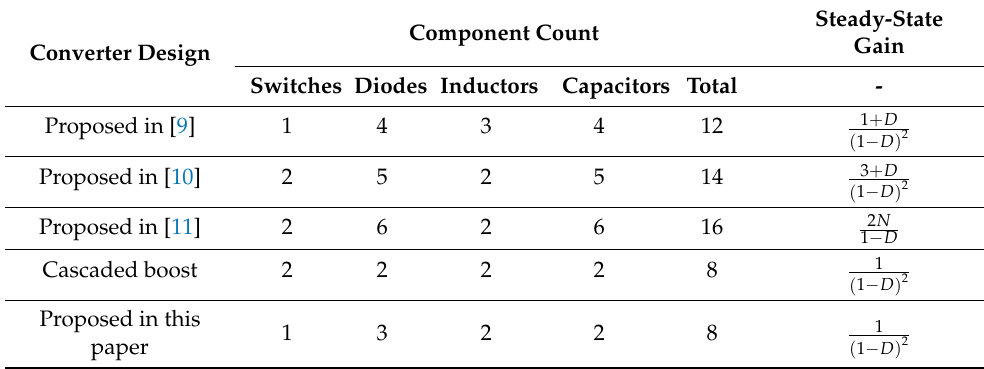
Table 2. Component count and steady-state gain comparison among different